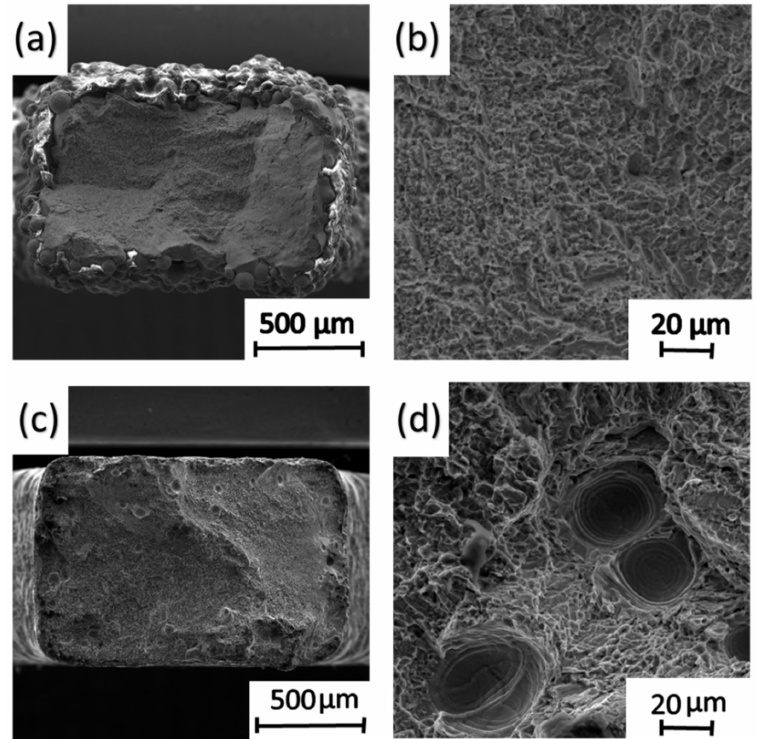
Figure 13. Fracture surfaces of ZXY specimens with 1 mm thickness: ( a ) produced by EBM, ( b ) detail of fracture in EBM sample, ( c ) produced by SLM and ( d ) detail of fracture in SLM